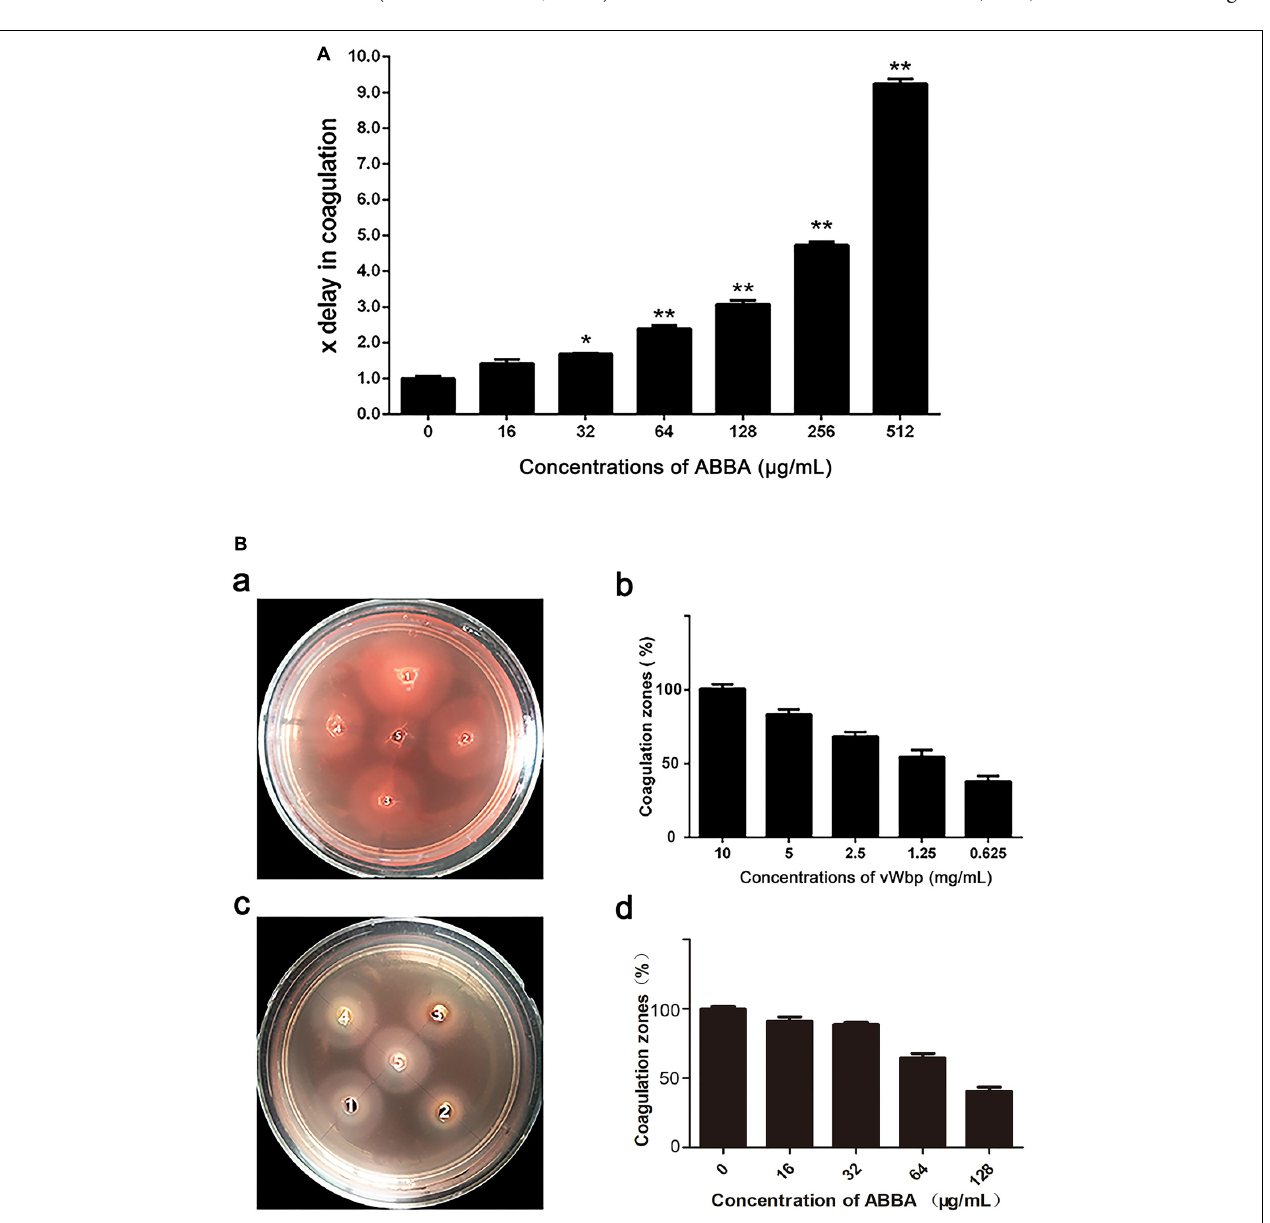
FIGURE 1 | ABBA inhibits S. aureus vWbp Activity in tube and plate coagulation tests. (A) Recombinant vWbp was added to freeze-dried rabbit plasma mixed with different concentrations of ABBA. The plasma was incubated at 37 ◦ C, and coagulation was monitored by laying the tube down on its side every 10 min. (B) Agarose plate coagulation assay: 2-fold dilutions of vWbp (from well 1 to 5) were added to wells punched in plates containing rabbit plasma. Coagulation zones were measured after incubation at 37 ◦ C overnight (a,b) ; 5 mg/ml vWbp was added to each well, and 128, 64, 32, and 16 µ g/ml ABBA was added from well 2 to 5. Coagulation zones were measured after incubation at 37 ◦ C overnight (c,d)